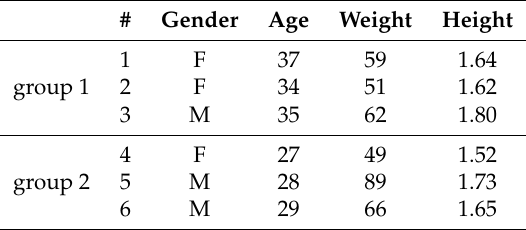
Table 4. General volunteer features for the falls collection: Group 1 is formed by performing artists and group 2 is formed by normal, healthy, young people. # Gender Age Weight Height 1 F 37 59 1.64 group 1 2 F 34 51 1.62 M